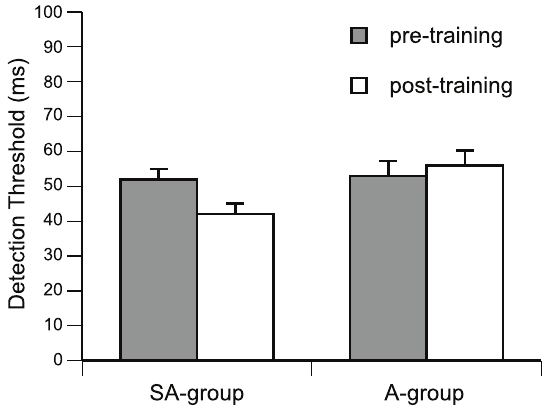
Figure 2. Group means of behavioral performance in the auditory discrimination test before and after training: pre, pretraining; post, postraining. Error bars indicate